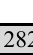
Expected demand of the retailers Demand for product 1 Demand for product 2